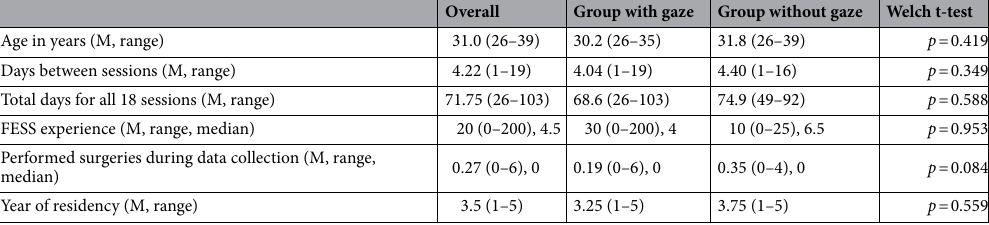
Table 1. Overview of participants.